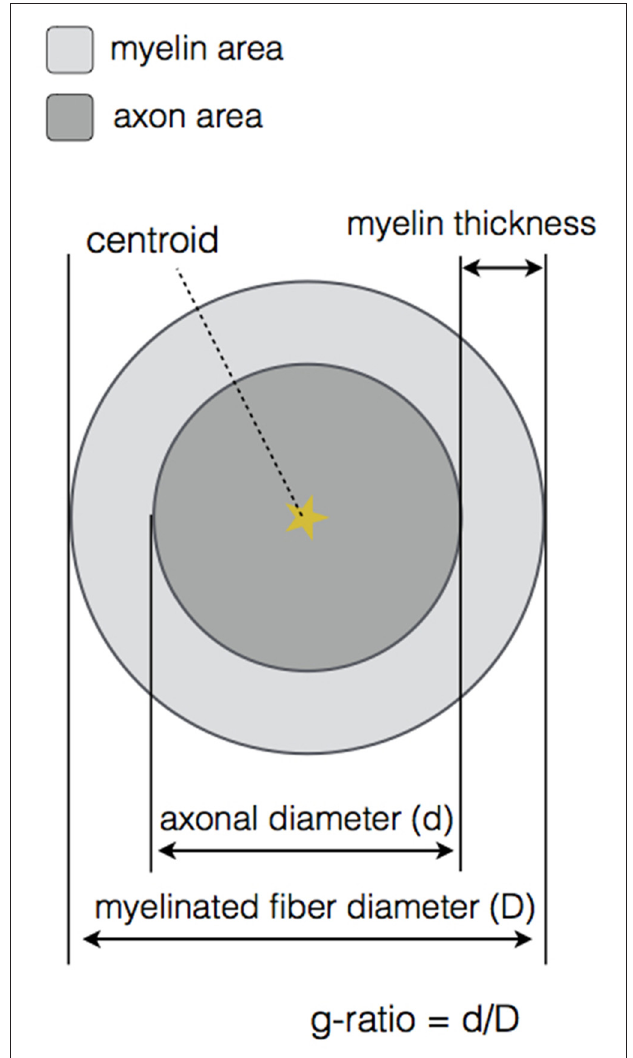
FIGURE 3 | Main morphological properties computed by AxonSeg. For each myelinated fiber, the centroid, the axon and myelin areas, the axonal diameter, the myelinated fiber diameter, the myelin thickness and the myelin g-ratio are